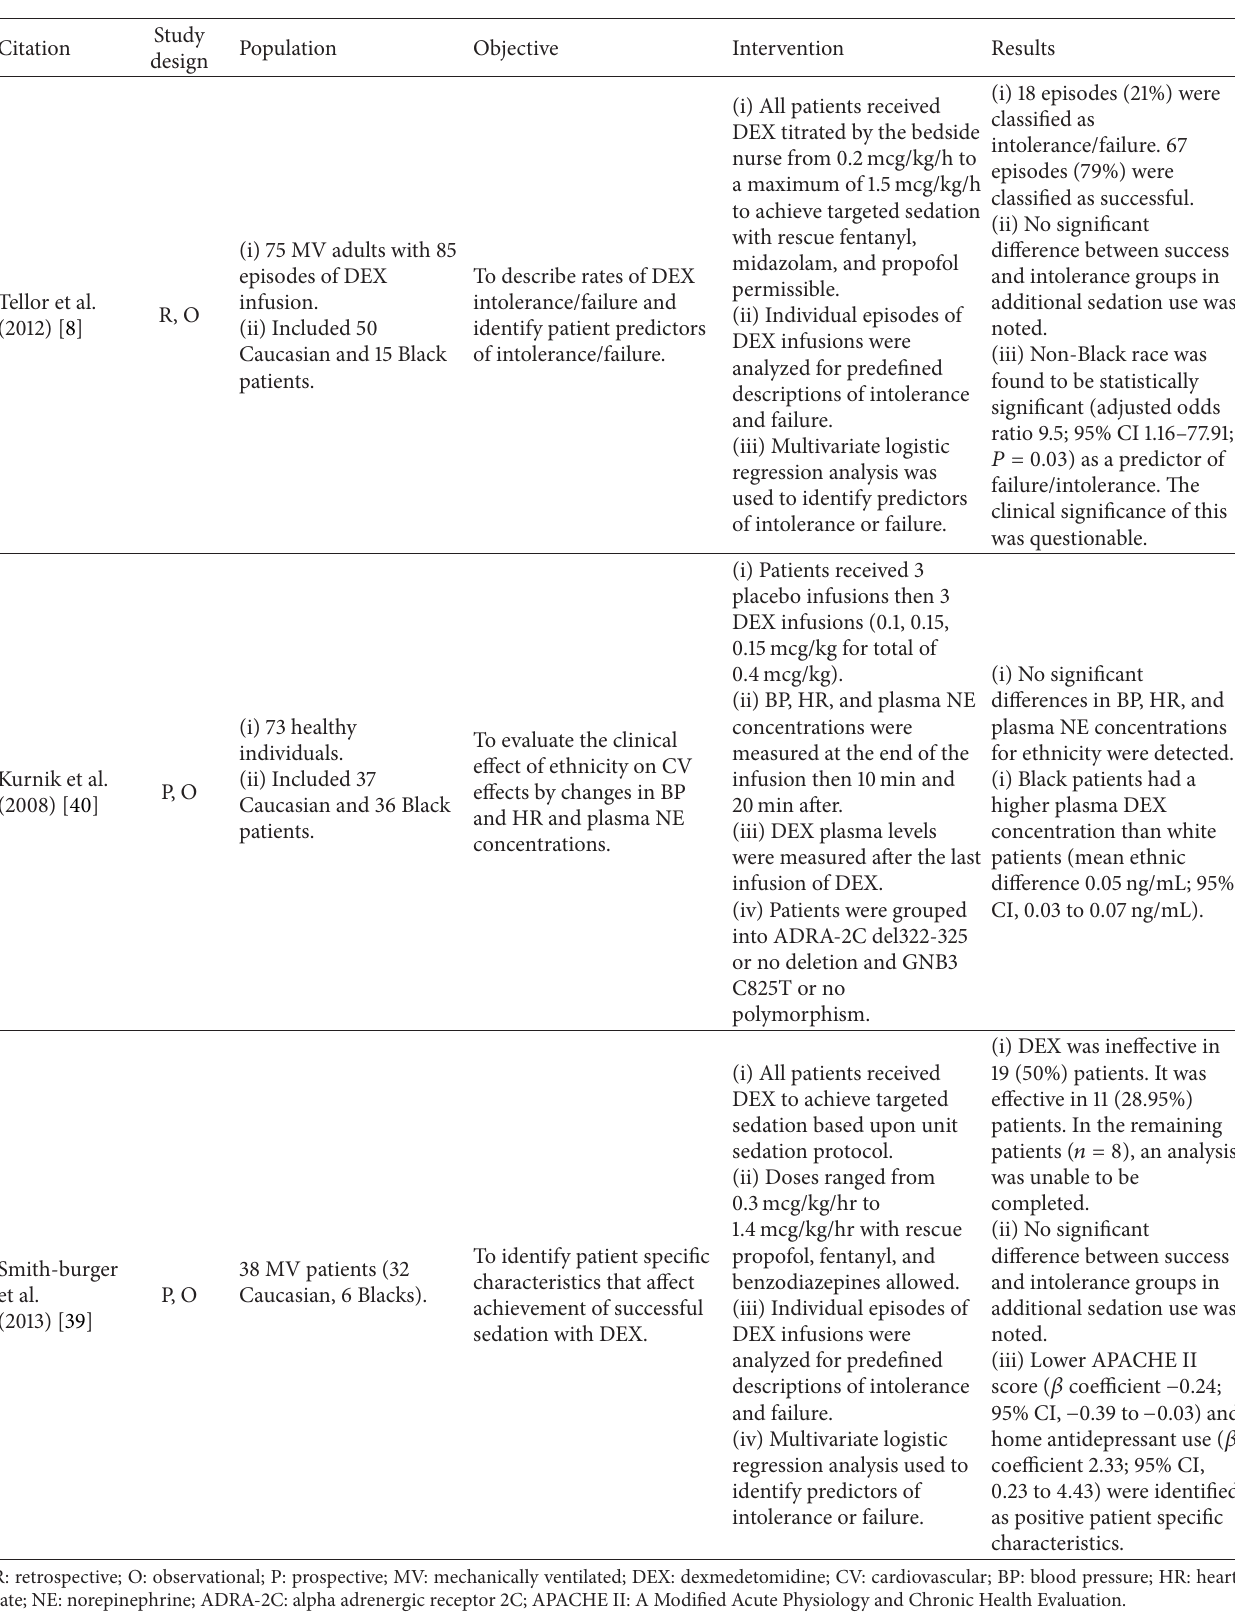
Table 1: Studies evaluating the role of patient